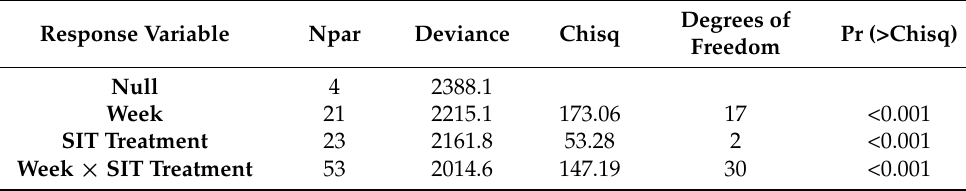
Table 2. Summary of test statistics for the likelihood ratio tests analysing the interaction between D. suzukii infestation, SIT treatment and time of the year (week).